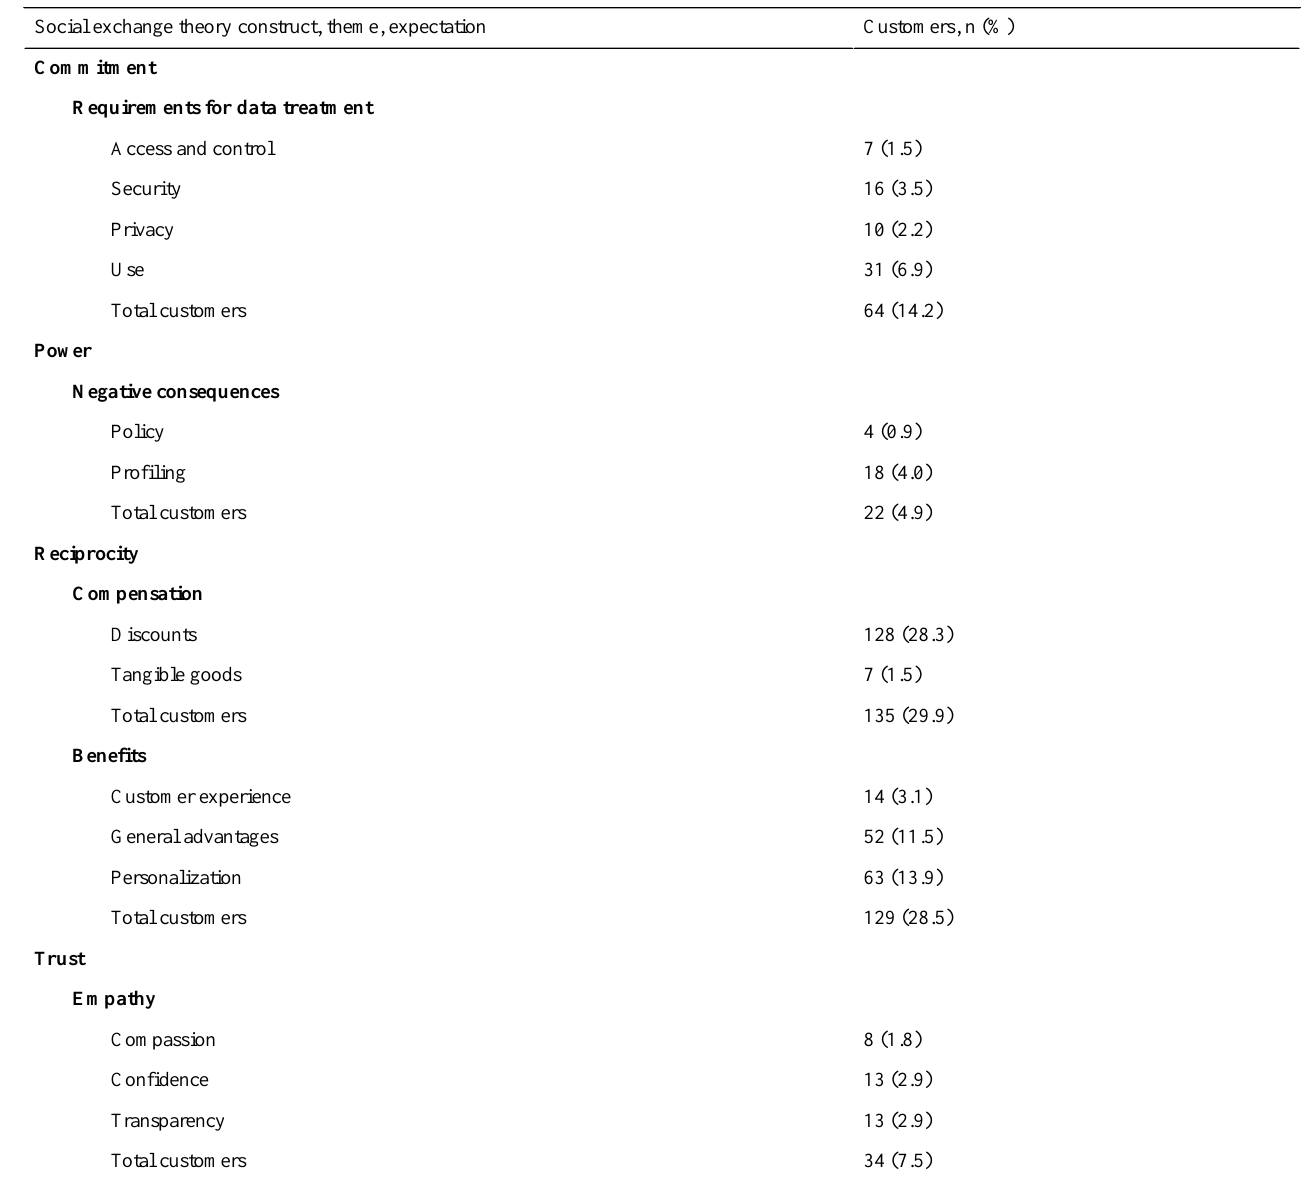
Table 3. Expectations of insurance customers for sharing health data